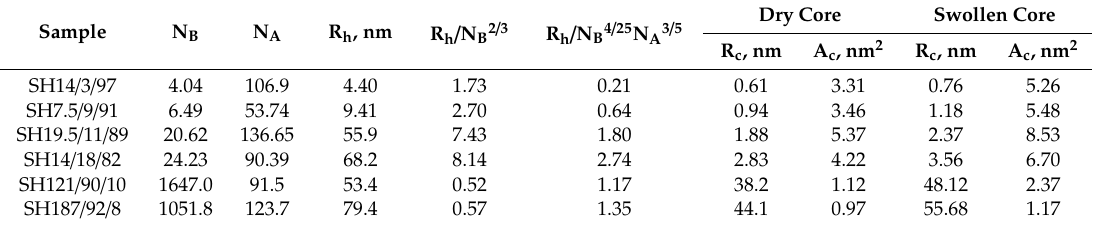
Table 2. Structural characteristics of the SH block copolymers micelles in